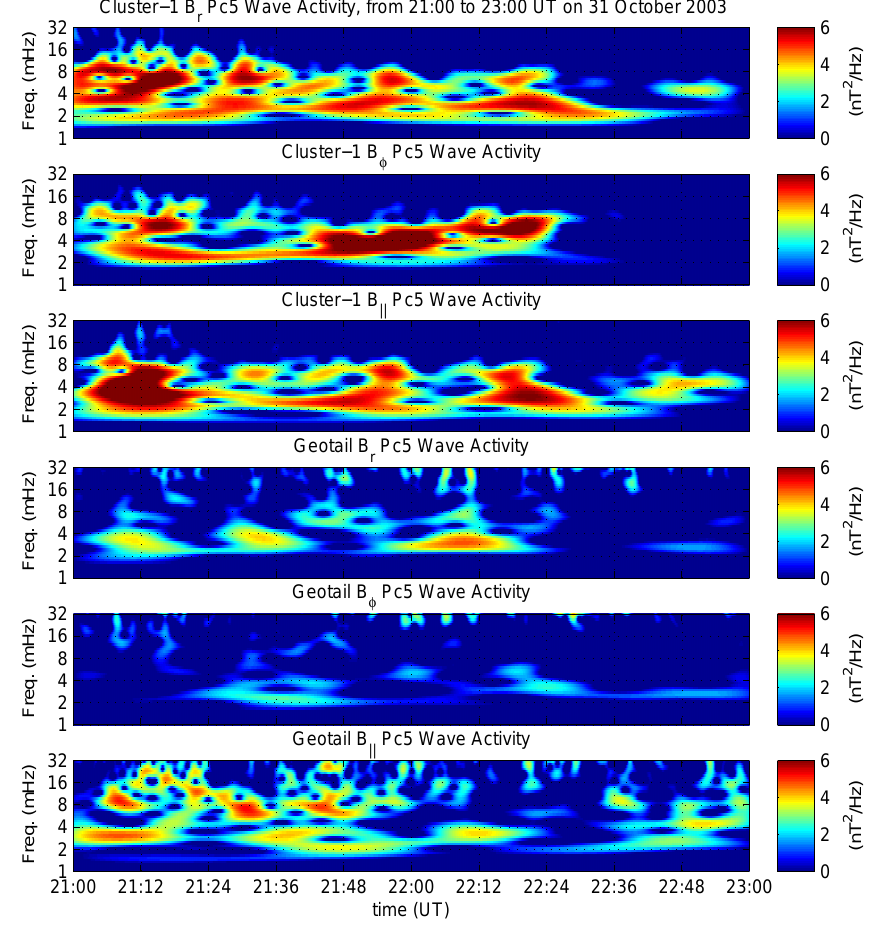
Fig. 14. Event 3: 21:00–23:00UT, 31 October 2003. As in Fig. 12.